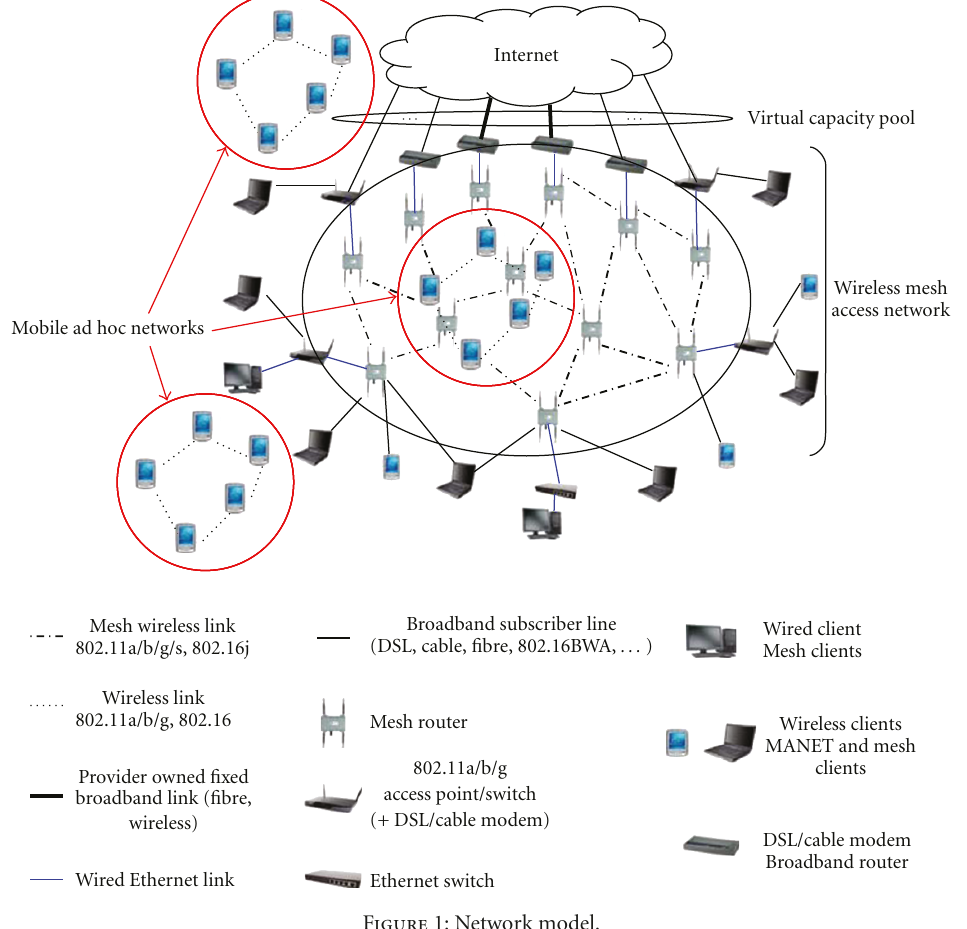
Figure 1: Network